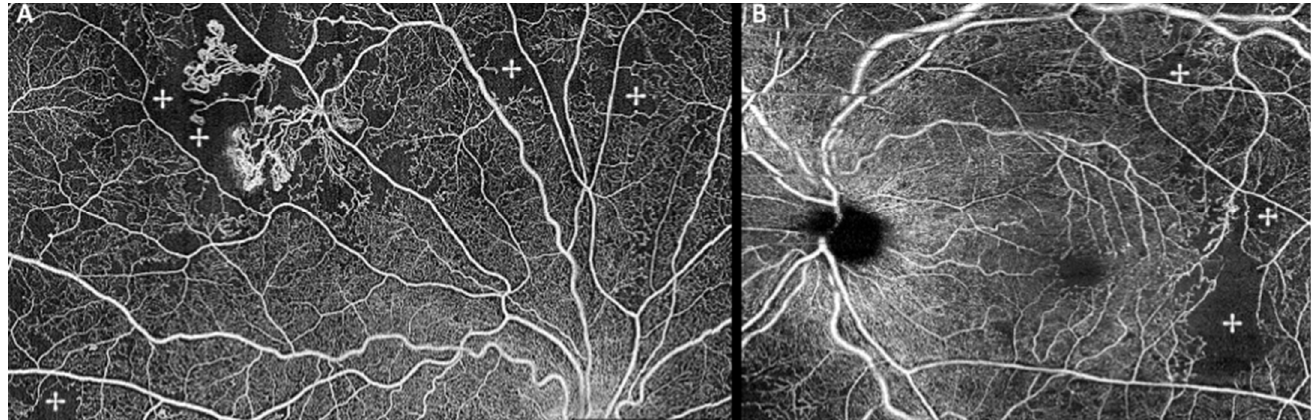
Figure 5. En-face SS-OCTA 8 × 8 mm montage ( A ) of a PDR patient showing areas of retinal nonperfusion ( ✢ ) mostly in the superior retina with associated retinal neovascularization. SD-OCTA 8 × 8 mm montage ( B ) of a PDR patient showing significant areas of retinal nonperfusion ( ✢ ) with a relatively well-preserved foveal avascular zone.